Question: Write a caption explaining this figure to a reader.
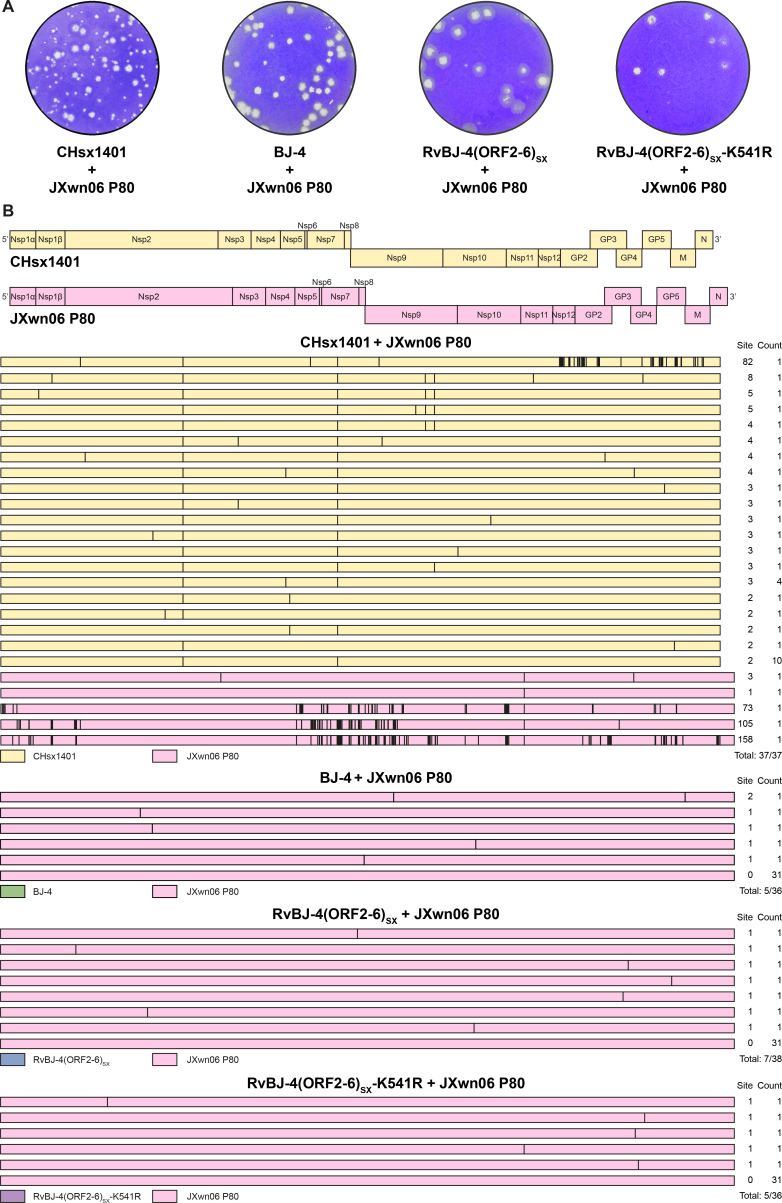
Answer: Plaque purification and genomic characterization of progeny viruses from JXwn06 P80 co-infection groups. ( A ) Plaque morphology observed by crystal violet staining. ( B ) Schematic of recombination breakpoints in plaque-purified viruses. Each horizontal bar represents a kind of viral genome. The background color indicates the major parental backbone, while the black vertical lines (|) indicate the precise recombination sites containing sequences derived from the co-infecting strain. “Site” indicates the total number of recombination breakpoints in a single sequence. Note: Due to scaling, some adjacent sites may appear merged; the exact count is provided in the “site” column. “Count” indicates the number of isolates exhibiting this specific recombination pattern. “Total” represents the proportion of recombinant sequences relative to the total number of viable viruses sequenced.